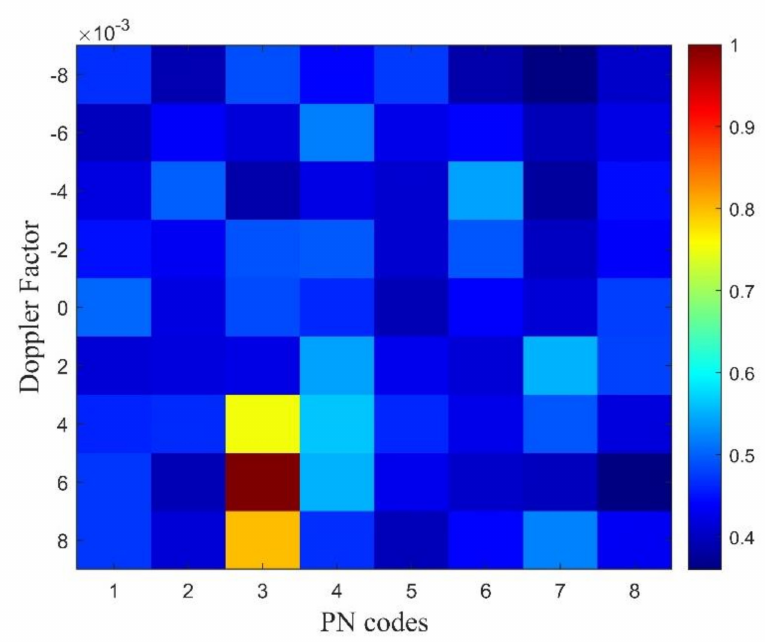
Figure 10. Coarse Doppler estimation based two-dimensional search results.